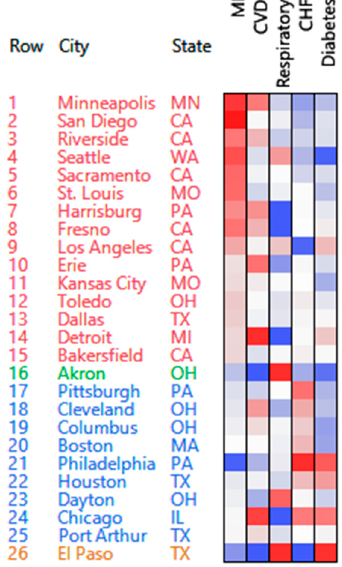
Figure 4. Affine NMF clustering. Red: High count; Blue: Low count.